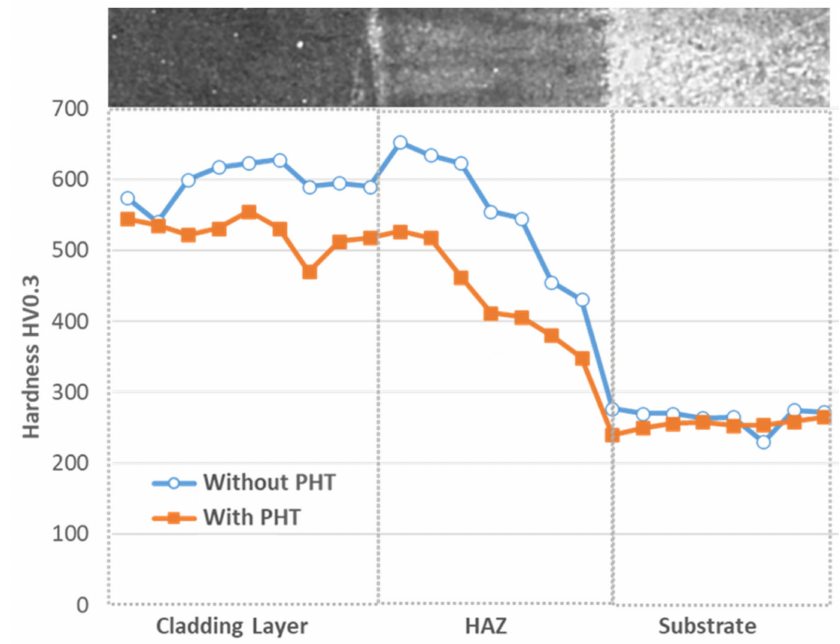
Figure 8. Microhardness profile of M2_6_15 samples with and without